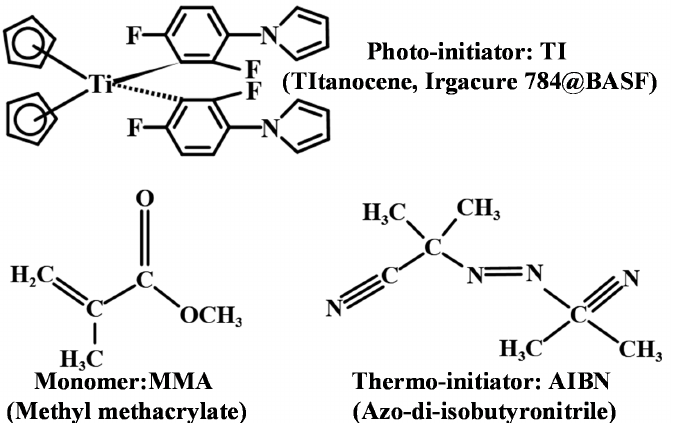
Figure 1. Chemical structures of the main solutes and solvent in TI/PMMA photopolymer sam-